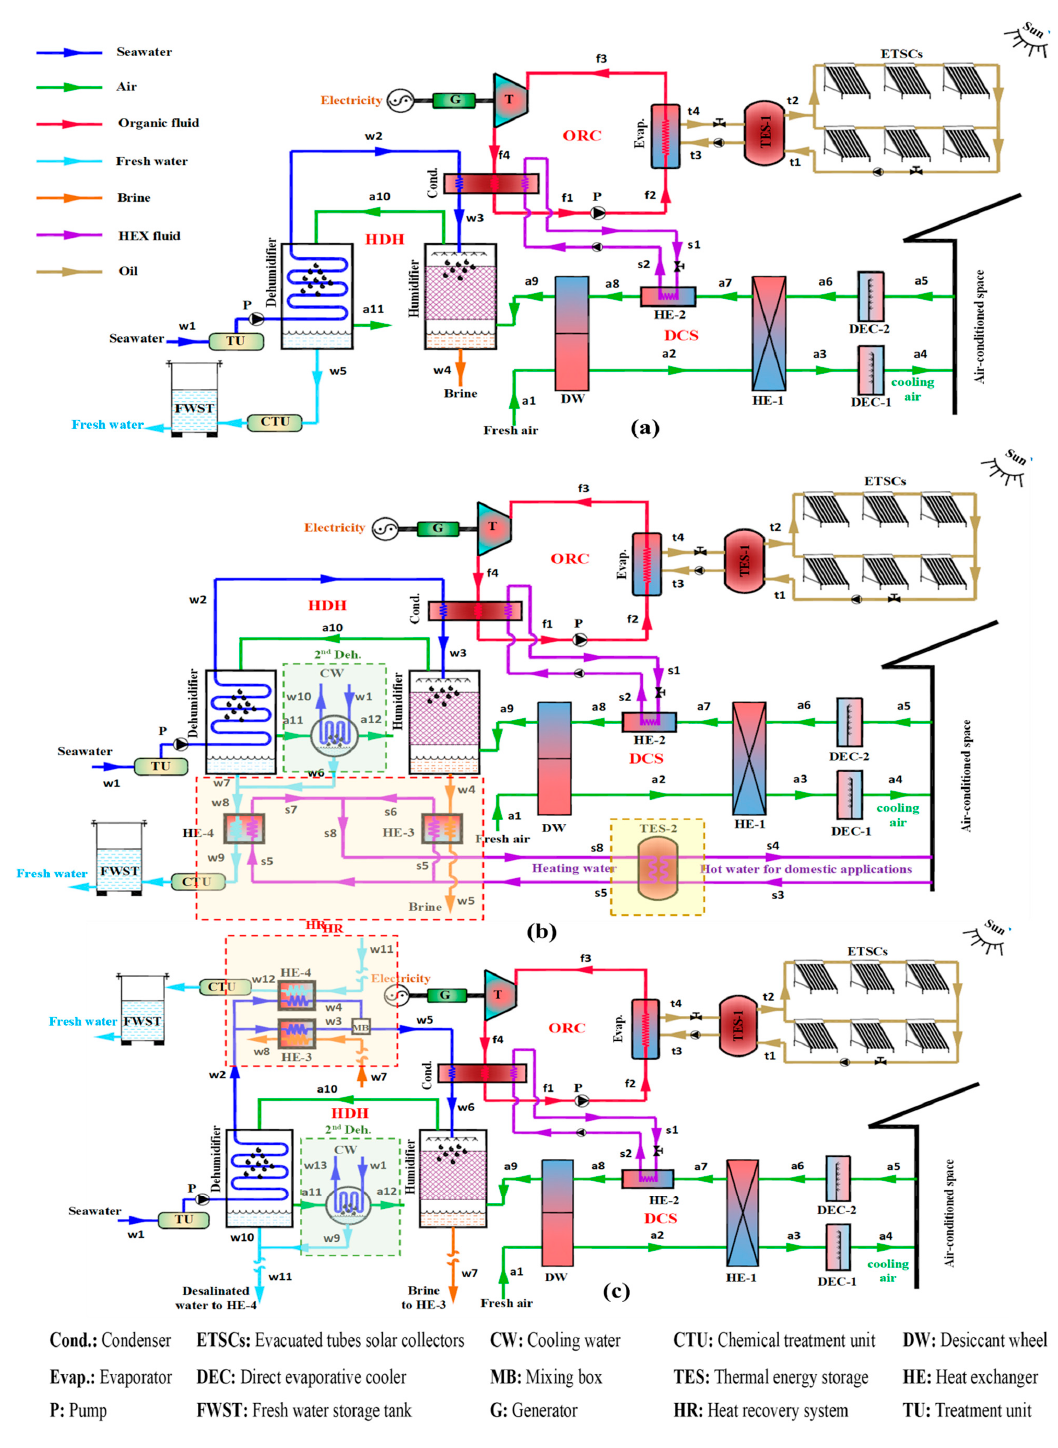
Figure 1. Schematic diagram of proposed multigeneration systems: ( a ) The basic system (BS), ( b ) the improved system-I (IS-I), and ( c ) the improved system-II (IS-II).